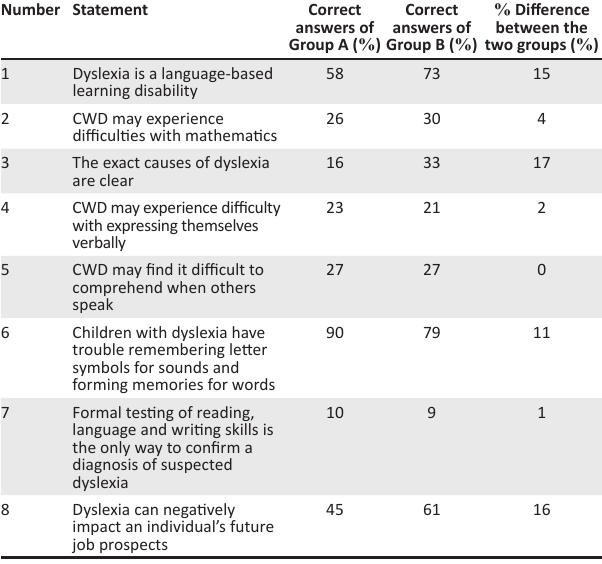
TABLE 2: Survey responses with percentage differences in the knowledge base. Number